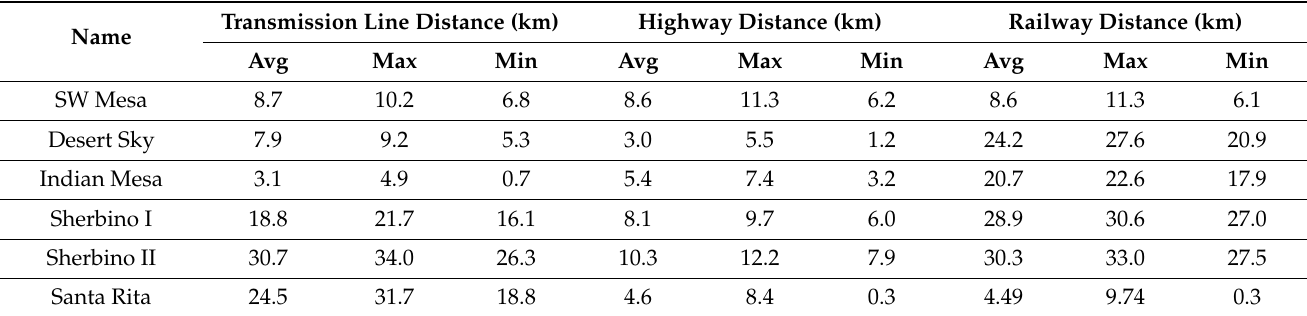
Table 2. Distance to infrastructure from a group of wind farms in central west